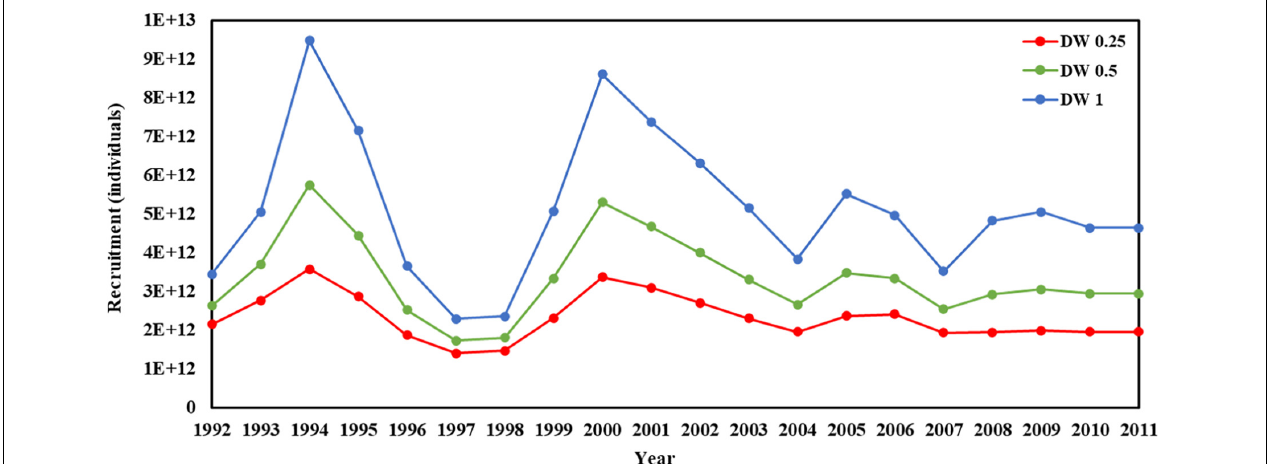
FIGURE 5 | Recruitment in 1992–2011 years (red line present weights in 0.25, green line present weight in 0.5, blue line present weight in